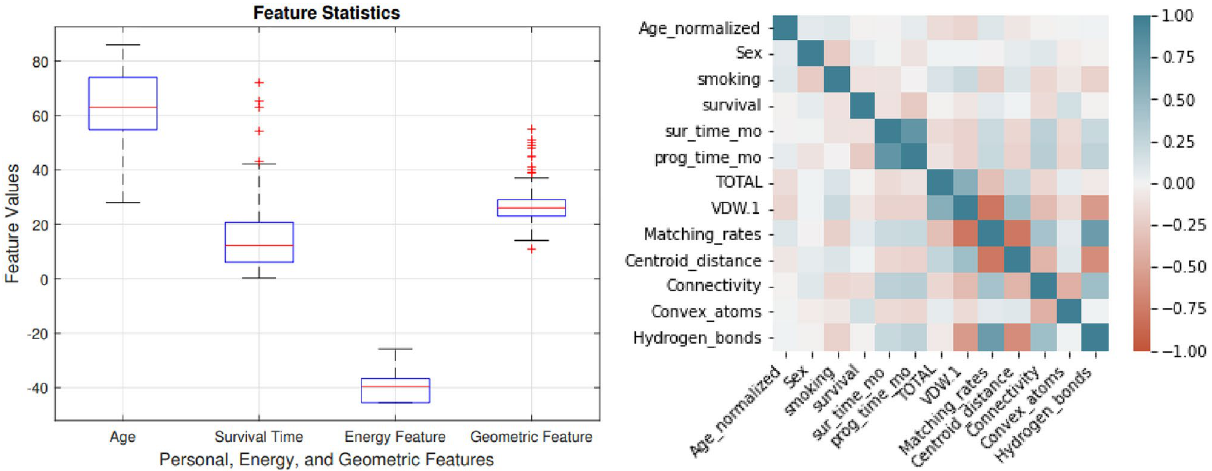
Figure 2. Box plot of normalized values for energy, and geometrical features (left panel), and correlation among features (right